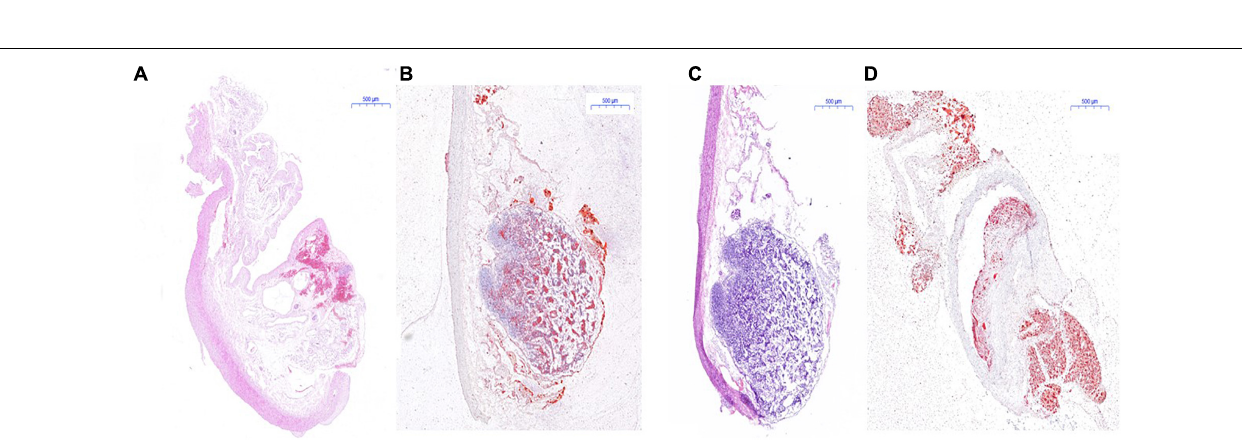
FIGURE 8 | Histological measurement of both ApoE – / – mice and rabbit. (A) H&E staining for the determination of atherosclerotic plaques area of rabbit; (B) red “O” staining for the determination of atherosclerotic plaques area of rabbit; (C) H&E staining of atherosclerotic plaques area of mice; (D) red “O” staining of atherosclerotic plaques area of